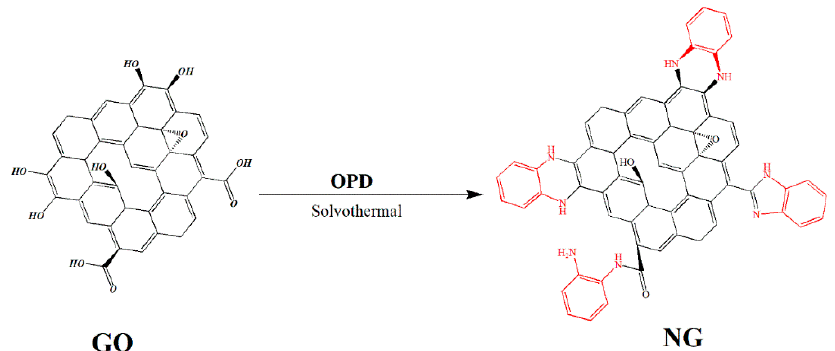
Figure 1. FTIR spectra of NG and RGO fillers.